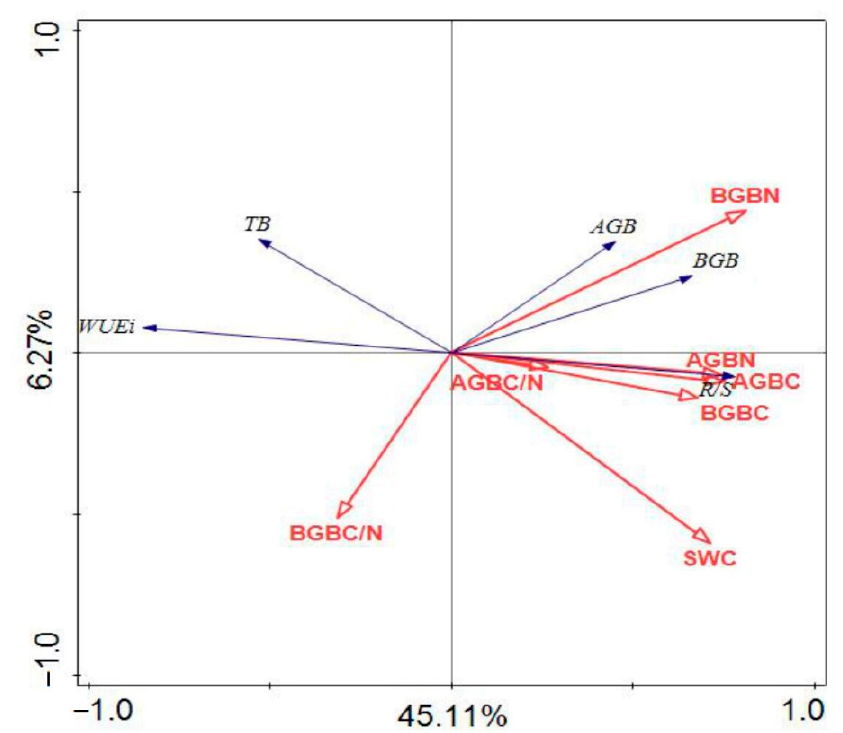
Figure 5. Redundancy analysis (RDA) of biomass, WUEi and C, N concentration, soil water content in 5 alpine grassland types. Aboveground biomass (AGB), Belowground biomass (BGB), total biomass (TB), BGB to AGB ratio (R/S), carbon concentration of AGB (AGBC), carbon concentration of BGB (BGBC), nitrogen concentration of AGB (AGBN), nitrogen concentration of BGB (BGBN), C to N ratio of AGB (AGBC/N), C to N ratio of BGB (BGBC/N), soil water content (SWC) and intrinsic water use efficiency (WUEi). Table 5. Correlation among aboveground biomass (AGB), belowground biomass (BGB), total biomass (TB), BGB to AGB ratio (R/S), carbon (C), nitrogen (N) concentrations, soil water content (SWC) and intrinsic water use efficiency